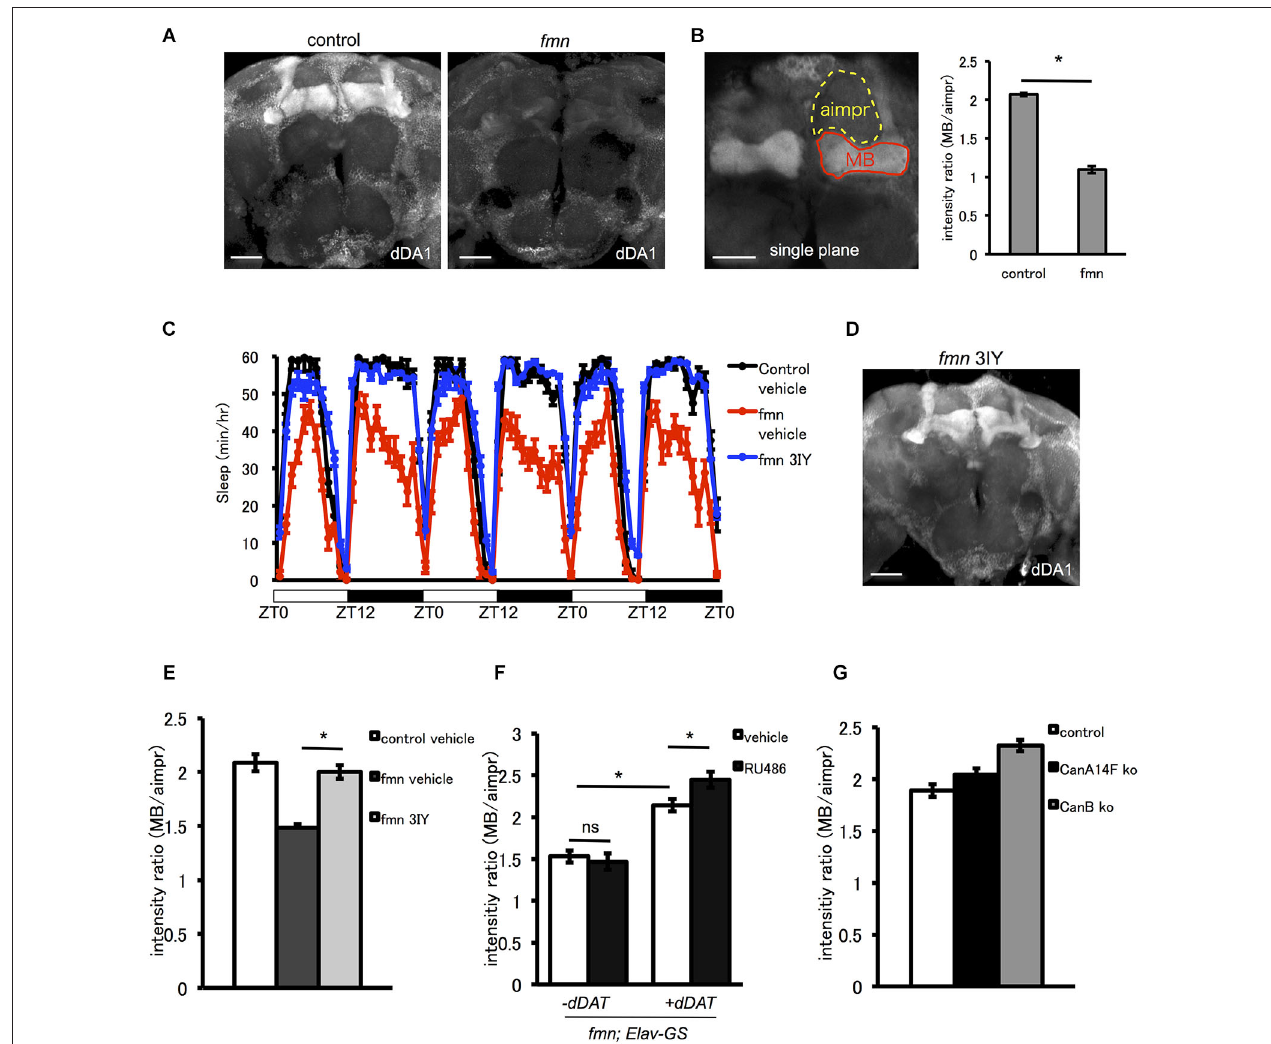
show sleep levels similar to the control ( n = 16 flies). (D) dDA1 expression was restored in fmn mutants fed with 3IY. dDA1 expression in